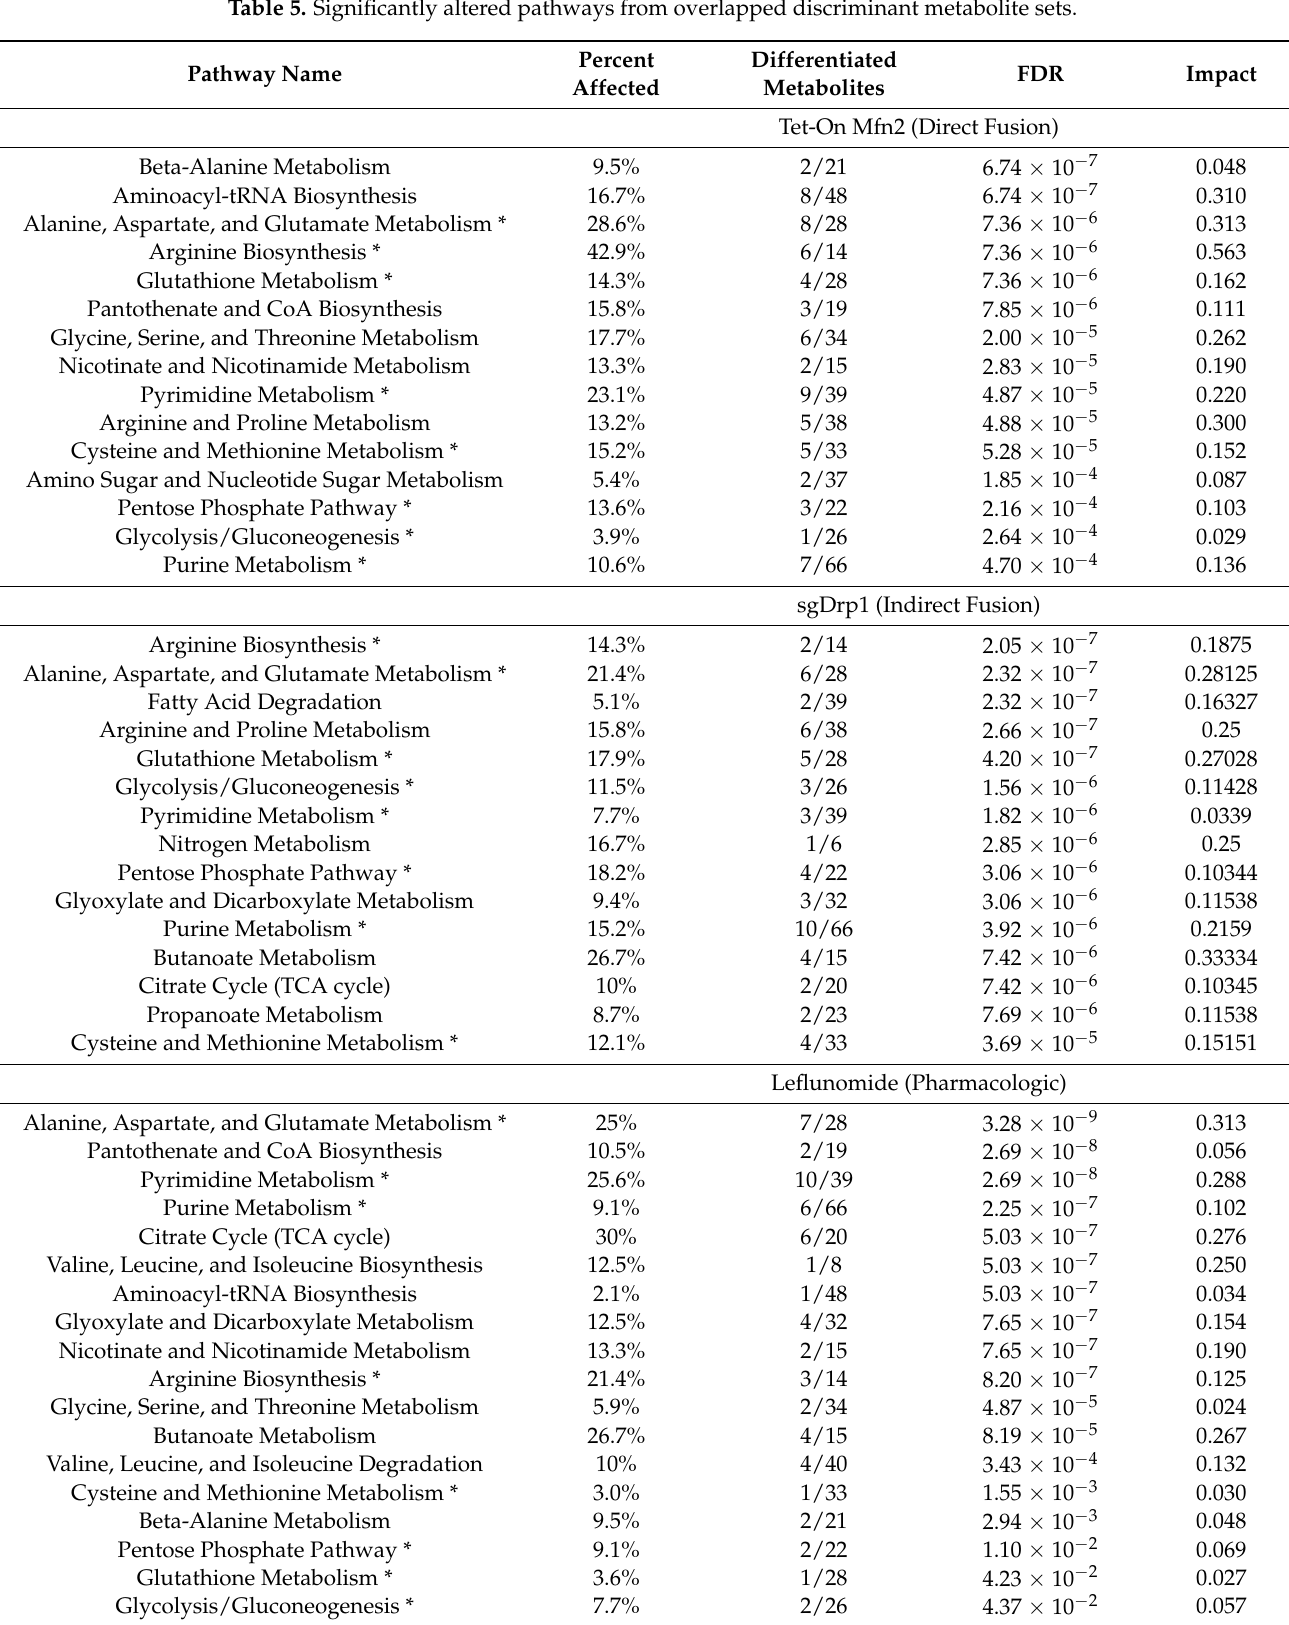
Table 5. Significantly altered pathways from overlapped discriminant metabolite